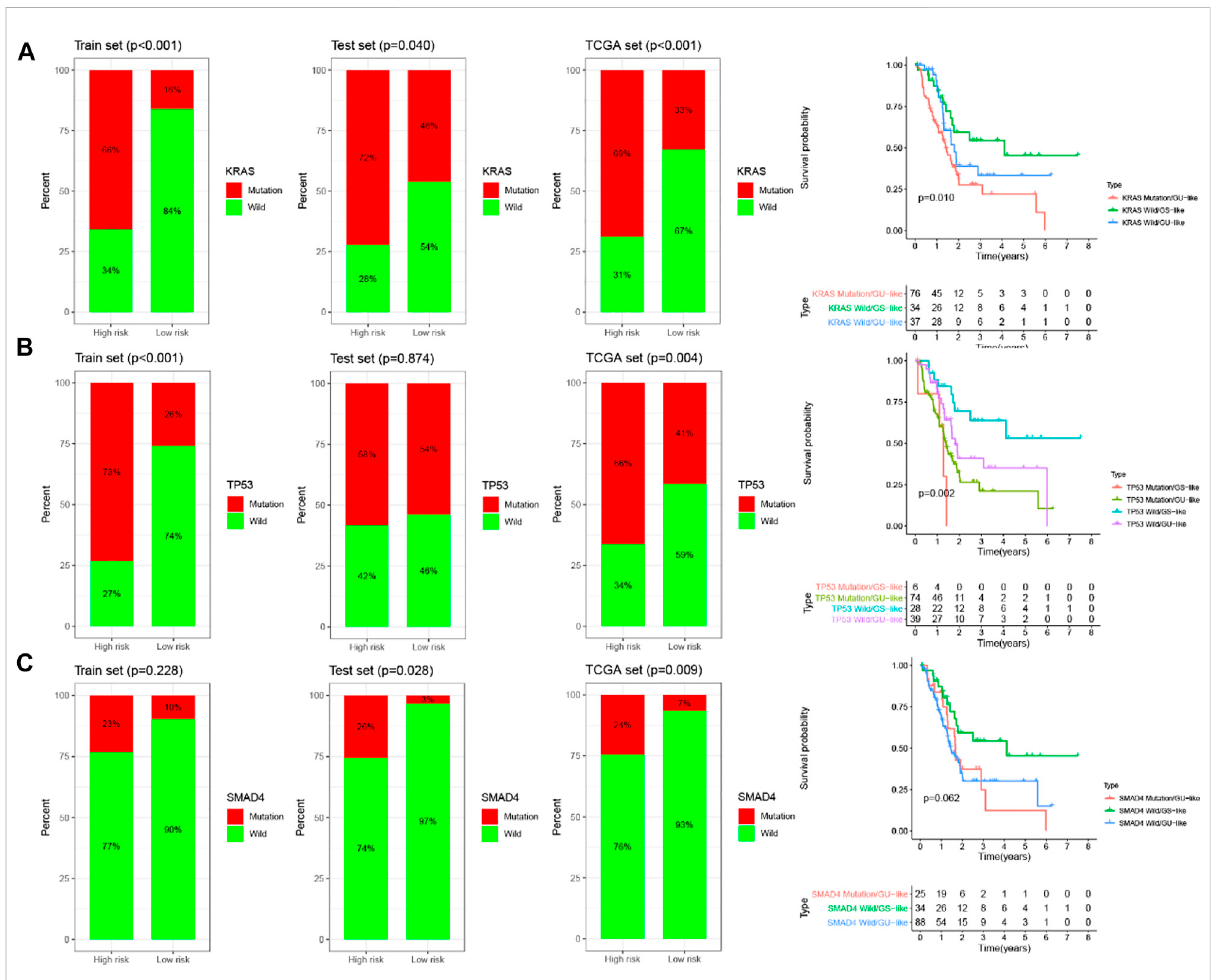
FIGURE 9 Relationship between the GILncSig and KRAS, TP53, SMAD4 mutation. The proportion of KRAS (A) , TP53 (B) , and SMAD4 (C) mutation in the high- and low-risk group in the training set, the testing set, and the TCGA set. Kaplan – Meier survival curves of overall survival for patients in